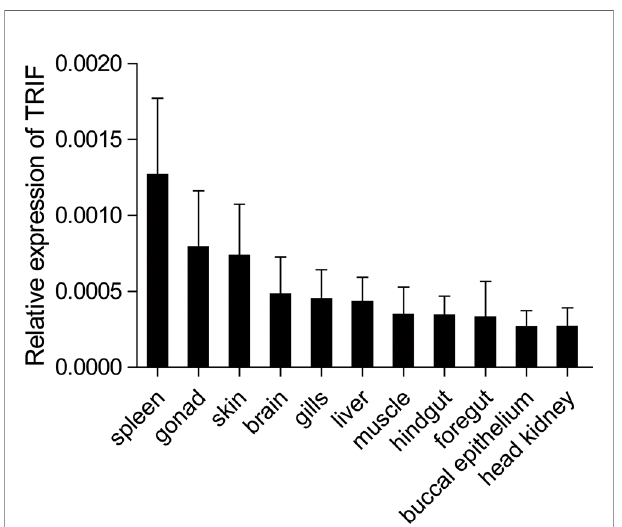
FIGURE 2 | Tissue expression of TRIF in normal common carp. The mRNA expression of carp TRIF in the liver, spleen, head kidney, foregut, hindgut, skin, gills, gonad, muscle, buccal epithelium, and brain was detected by real- time PCR. The 40S ribosomal protein s11 was ampli fi ed in each tissue sample as an internal control, n = 3.